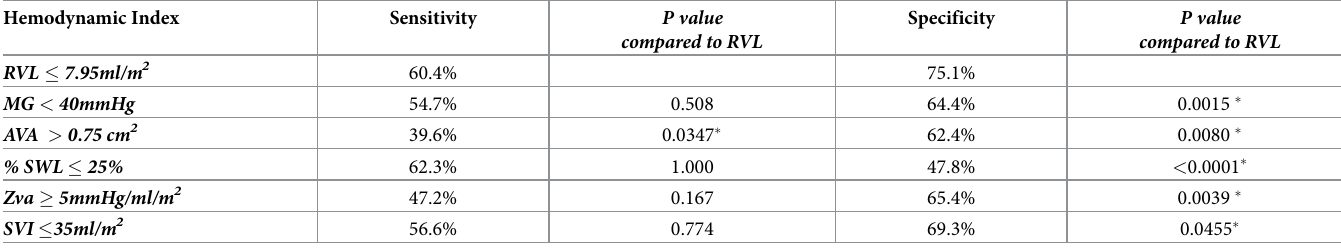
On ROC analysis, RVL had the largest area under the curve (AUC = 69.3%) for the predic- tion of all cause mortality at 1-year post-TAVR “Table 2”. The AUC for RVL was significantly greater than that observed for AVA (p = 0.003), %SWL (p = 0.008) and Zva (p = 0.032), but not statistically larger than MG (p = 0.165) or SVI (p = 0.32) “Table 2”. The best cut-off value for predicting all cause mortality at 1-year post-TAVR was an RVL (cid:20) 7.95ml/m 2 , which pro- vided a sensitivity and specificity of 60.4% and 75.1%, respectively “Table 3”. The specificity of RVL (cid:20) 7.95ml/m 2 was significantly larger than obtained using MG < 40mmHg (p = 0.002), AVA > 0.75cm 2 (p = 0.008), %SWL (cid:20) 25% (p < 0.001) Zva (cid:21) 5mmHg/ml/m 2 (p = 0.004), and SVI (cid:20) 35ml/m 2 (p = 0.045), despite similar or greater sensitivity “Table 3”. Univariate analysis of clinical and hemodynamic prognostic variables in patients with RVL (cid:20) 7.95ml/m 2 and > 7.95ml/m 2 are summarized in “Table 4”. Patients with RVL (cid:20) 7.95ml/m 2 had a higher preva- lence of atrial fibrillation and LVEF (cid:20) 40%, and a higher Euroscore II compared to patients with RVL > 7.95ml/m 2 . When adjusting for these variables in Cox proportional hazard model, RVL continued to show statistical significance as a predictor of all cause mortality 1-year post- TAVR (HR 3.2, CI 1.8–5.9; p < 0.0001). Kaplan-Meier survival curves for the two most specific indices (RVL and SVI) for predict- ing all cause mortality are shown in “Fig 2”. Survival at 1-year post-TAVR was 88.0% for patients with RVL > 7.95ml/m 2 and 61.4% for patients with RVL (cid:20) 7.95ml/m 2 (27% margin of difference, p < 0.0001). Using an SVI cut-point of 35ml/m 2 , the margin of difference for all cause mortality at 1-year post-TAVR was smaller at 18% (p = 0.0005). Table 3. Comparison of the sensitivity and specificity of hemodynamic indices for predicting all cause mortality 1-year post-TAVR. Hemodynamic Index Sensitivity P value Specificity P value compared to RVL compared to